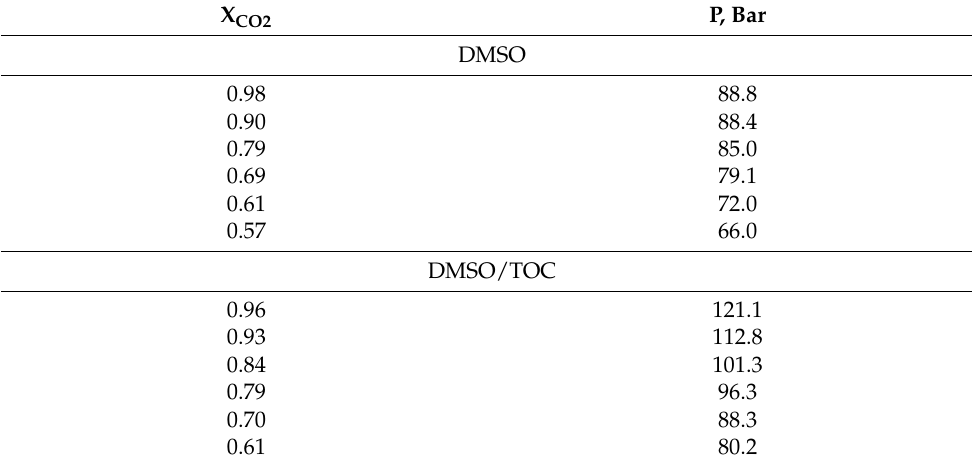
Table 2. Experimental data for DMSO/CO 2 /TOC system at 313